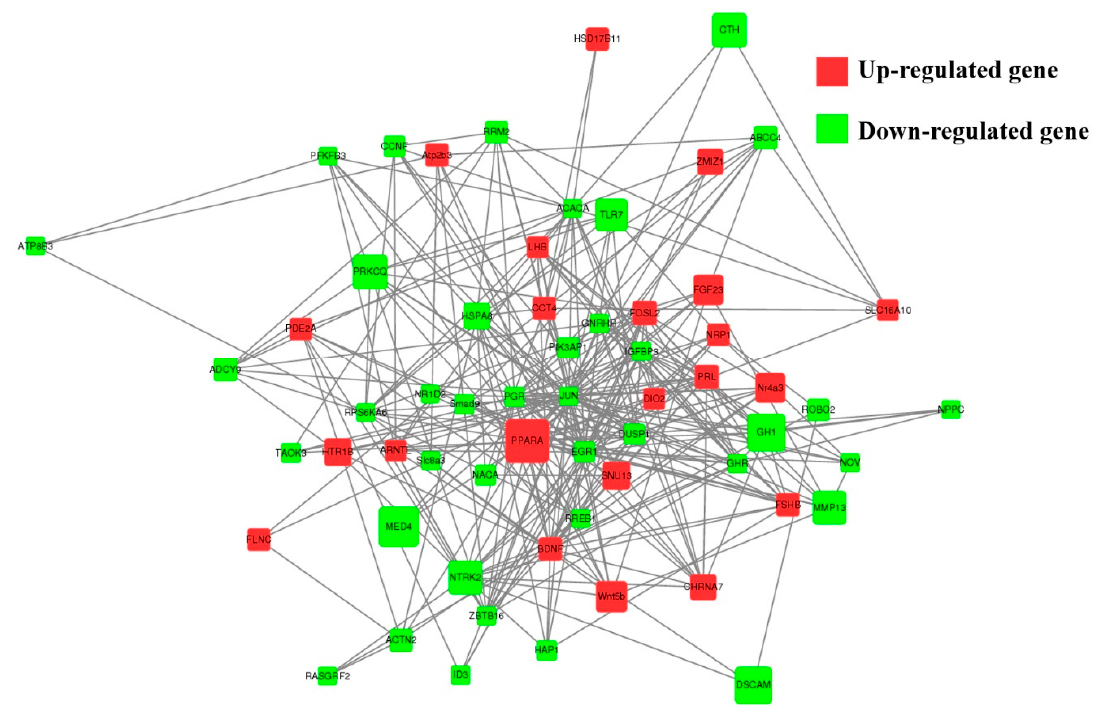
Figure 6. The network of 61 screened DE genes. The network of 61 screened DE genes enriched for Hu sheep pituitary functions and reproduction-related pathways were constructed, the red and green circles represent upregulated and downregulated DE genes, respectively. Node size represents the fold change of a node.